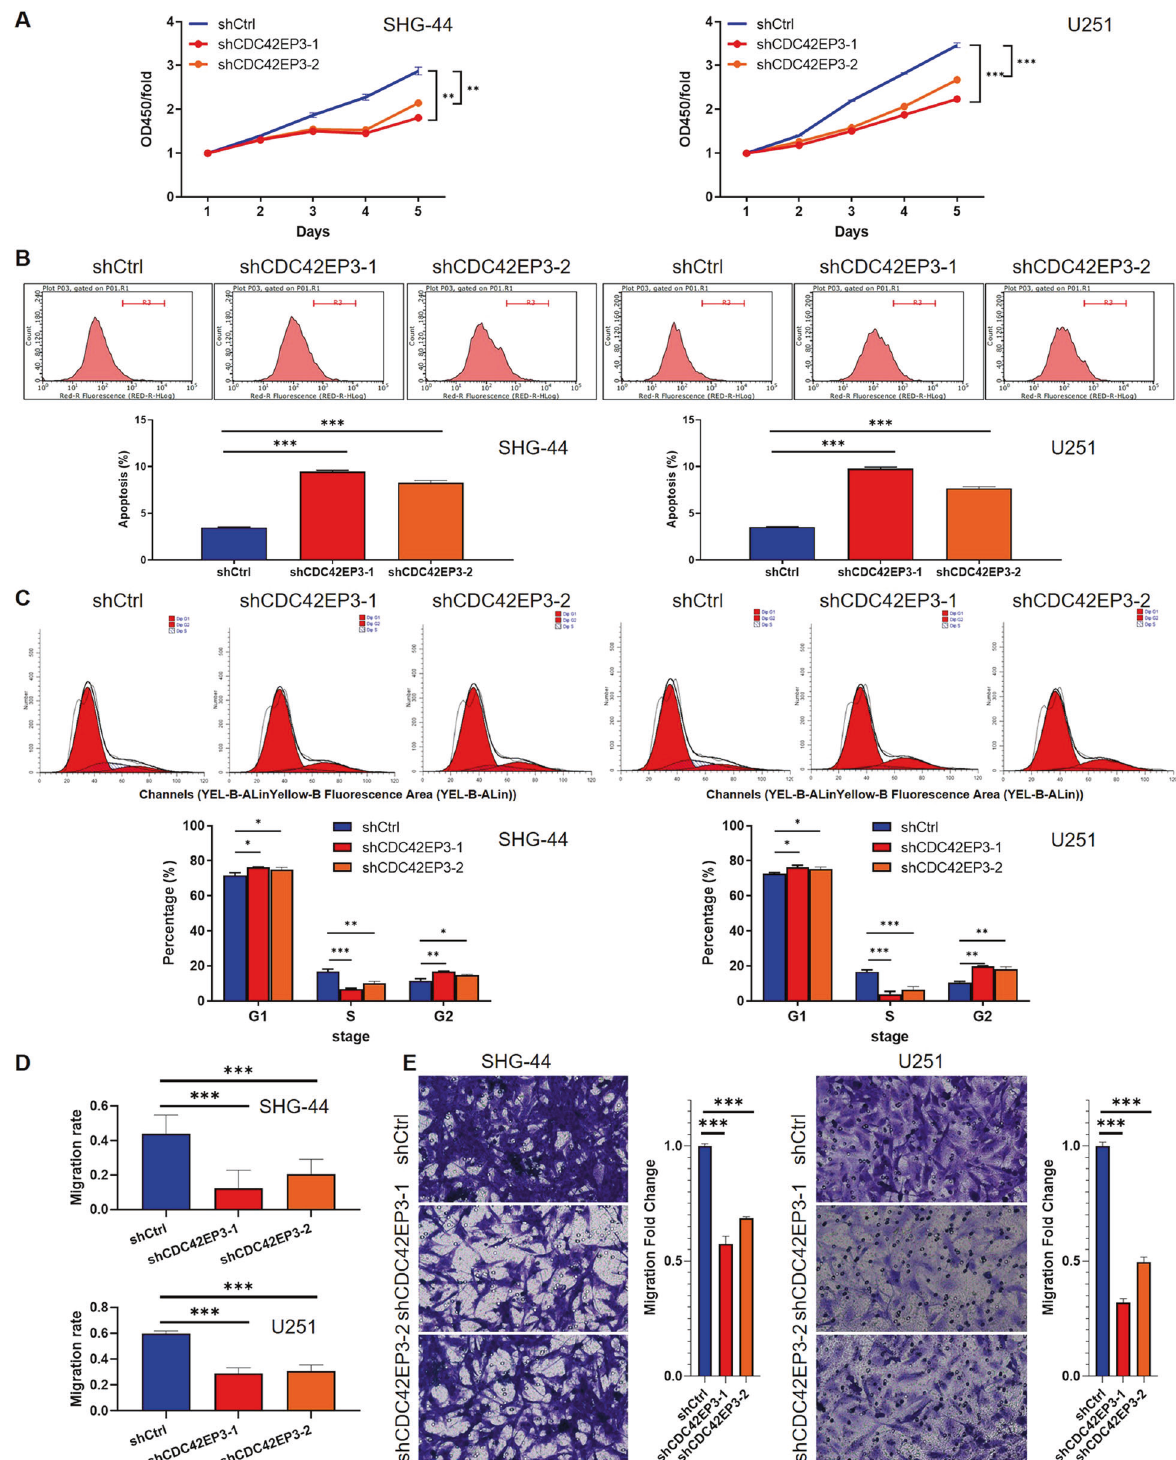
Fig. 2 Effects of CDC42EP3 depletion on cellular phenotypes in vitro. A Results of CCK8 assay indicated a signi fi cant inhibition on cell proliferation after depleting CDC42EP3 in SHG-44 and U251 cells. B Higher level of cell apoptosis following downregulation of CDC42EP3 than controls was detected by FACS (shCtrl vs . shCDC42EP3) in both cell lines. C Comparison of percentages of cells in three cell cycle phases (shCtrl vs. shCDC42EP3) in both experimental cell lines. D Representative images and differences on cell migration rate detected by wound-healing assay (shCtrl vs. shCDC42EP3) in both cell lines. E Representative images (×200) and the comparison on cell migration ability resulted from Transwell assay on the experimental cells. The left panel lists results for SHG-44 cells and the right panel is for U251 cells. Data were presented by mean with SD ( n ≥ 3). * P < 0.05, ** P < 0.01, *** P < 0.001.